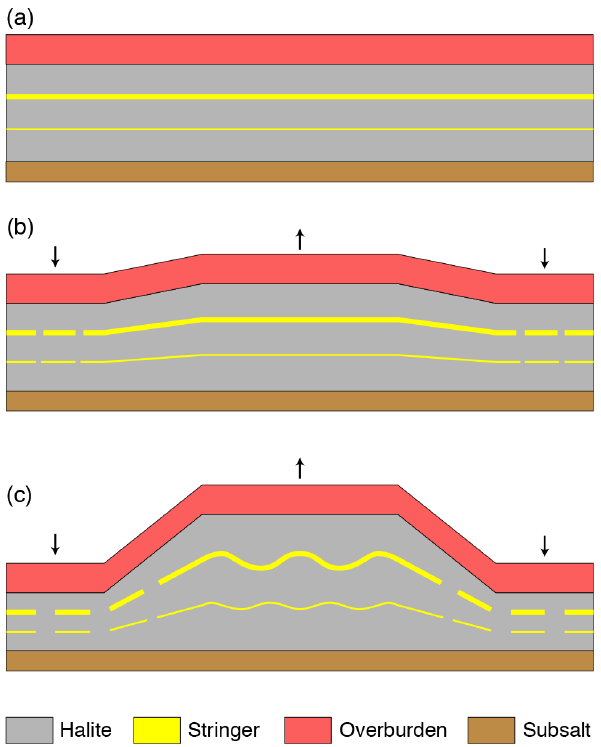
Figure 10. Conceptual diagrams of salt inflation and deflation due to the application of a differential sedimentary load (not shown), with two-dimensional flow of salt only within the model area (salt to right and left of model flows into adjacent salt pillows): (a) un- deformed salt layer with two competent internal beds of differing thickness; (b) incipient salt movement into salt pillow, with boud- inage of strong layers beneath depocenters and folding within pil- lows; (c) further deformation of intrasalt layers due to increasing deflation/inflation, with greater amounts of strain at shallower lev- els if there is insignificant mixing of halite above and below each competent